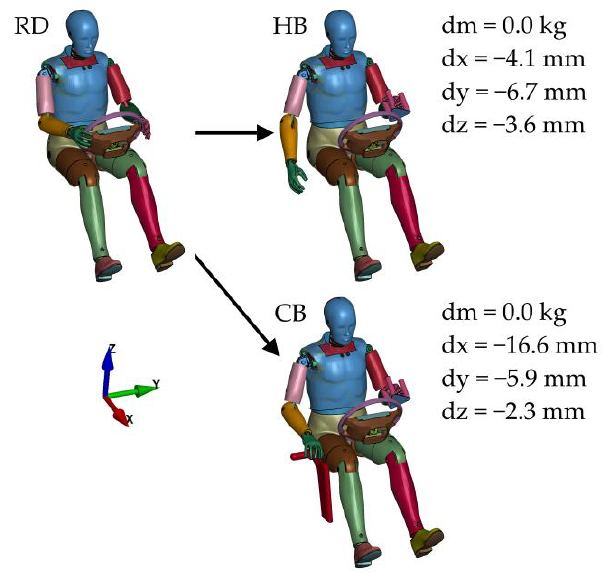
Figure 4. First stage of dummy model modifications.